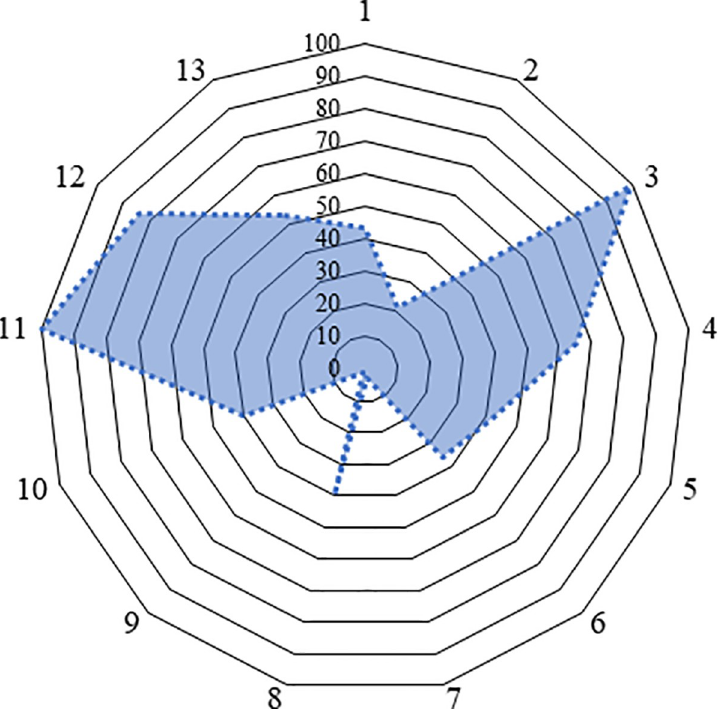
Fig 2. Knowledge assessment of cattle handlers for different questions in the study questionnaire. [(1) Do you know tuberculosis (TB) can be transmitted from animals to humans or humans to animals as a zoonosis? (2) What is the causal agent of TB? (Virus/bacteria/fungus/ other), (3) Do you know tuberculosis is an important public health problem in Bangladesh (Yes/No), (4) What are the symptoms of TB in humans? (Fever/swollen lymph glands /respiratory distress/coughing: � 2 weeks)/ Others)(at least two), (5) How do humans get infected with TB? (at least two) (consumption of raw/ improper boiled milk/ contact with infected animal (through aerosol)/contact with another infected person/butchering of infected animal/ contact/ consuming raw meat/improper cooked meat of infected animal/ others), (6) Are animals, including wild species, at risk for TB infection? (Yes/No), (7) What are the symptoms of TB in animals? (at least two) (fluctuation of temperature/progressive emaciation/rough hair coat/chronic coughing /presence of dyspnea/ presence of nasal discharge/enlargement of lymph node), (8) Why do you think that your cattle are not at risk of becoming sick by this disease? (maintaining bio-security/ regularly vaccination/ do not let them out of shed/conduct tuberculin skin tests (TST) and to exclude positive reactors from the herd), (9) Do you know animal movement/ purchase of a new animal is responsible for TB transmission in your farm? (Yes/No), (10) Will the boiling of milk kill the milk borne pathogen including the TB bacteria? (Yes/No), (11) Is zoonotic TB in humans curable? (Yes/ No), (12) What type of treatment is available for TB? (modern/traditional /religious believes) and (13) Do you know TB treatment is free of cost and available at the DOTS centers located throughout the country?